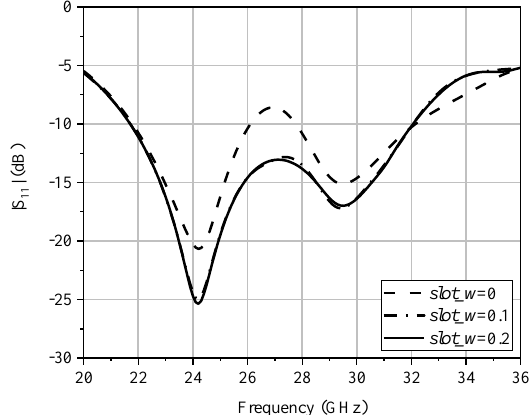
Figure 6. Simulated |S11| of the 5 × 1 interconnected ME dipole array versus slot w . For the 1-D interconnected ME dipole array along the E plane, the width of the mi- crostrip line is of importance to control the input impedance. As the number of radiating elements along the E-plane direction increases, the capacitance between the feeding patch and the shorted vias at the inner edge of the electric dipole increases, which can be com- pensated by increasing the inductance of the microstrip line. Figure 7 shows the input impedance of a 1 × 5 interconnected array along the E plane. Note that the |S 11 | value decreases from − 5 dB to − 11 dB as the width of the microstrip line decreases from 0.1 mm to 0.4 mm, and the resonant frequency basically remains invariable.